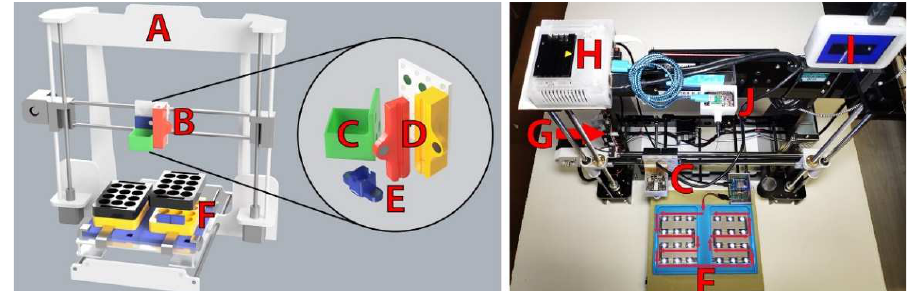
Figure 1. General design of the device. Our machine has been made from the chassis of an AnetA8 3D printer (A) whose plastic extruder has been removed and replaced by a magnetic support (B) to install a digital camera (C) and a lens (E) to obtain an optical magnification of 50×. A support for a micropipette tip has been added (D) to allow deposition of samples in two multi-well plates of twelve wells with transparent bottom (F) fixed on the bed of the 3D printer above 24 RGBW addressable LEDs (SK6812). The motherboard of the printer (G) has been modified to be controlled by a single board computer (Jetson Nano) (H) which captures the image of the camera and displays it in real time on the LCD screen (I). A second security camera (J) has also been added to monitor the remote operations.